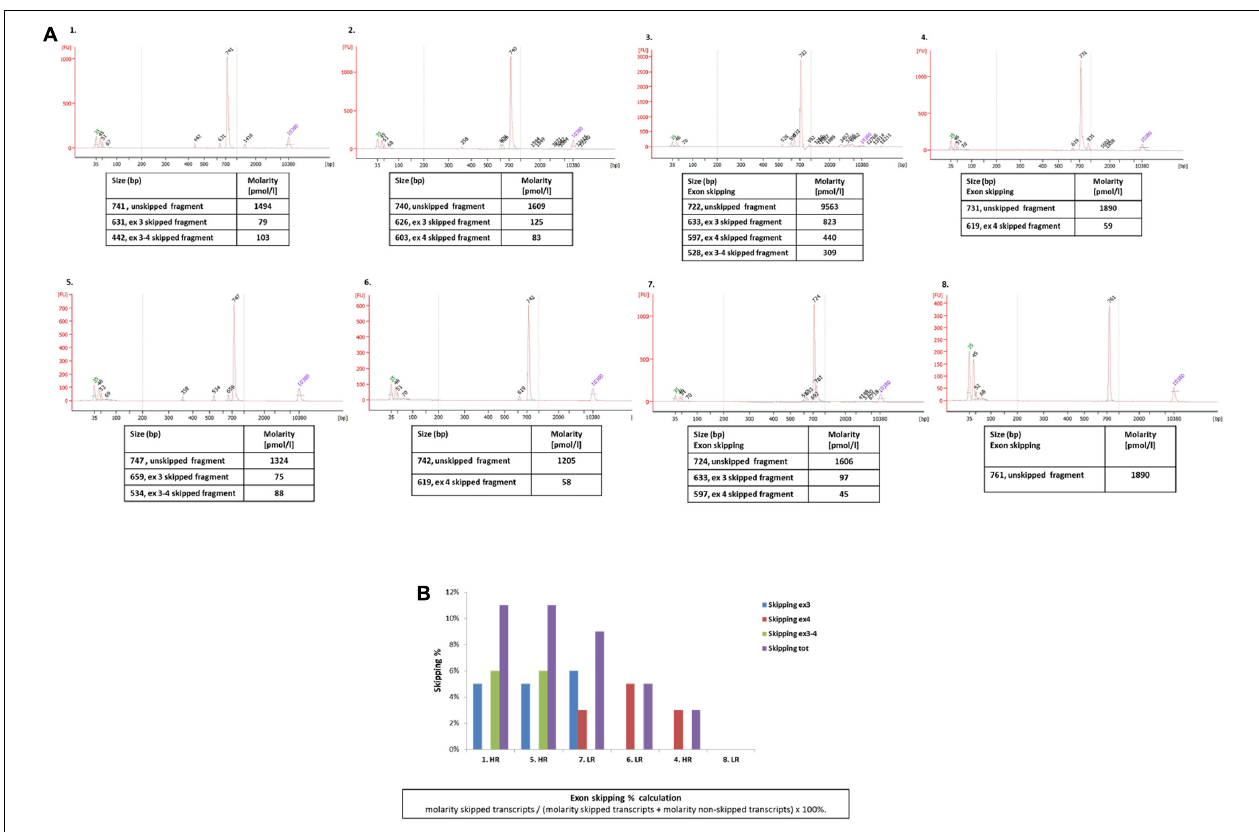
FIGURE 3 | (A) The chromatograms show the size of the amplified fragments (exons 2–7) of TNFRSF10A genes of the 8 DMD patients listed in Table 1C . Concentrations (Molarity) related to the unskipped and skipped fragments are reported in the tables below the chromatograms; (B) the plot summarizes exon 3, exon 4, exons 3 and 4, and all exons skipping percentage. Patients are ordered in the graph based on their total skipping percentage higher